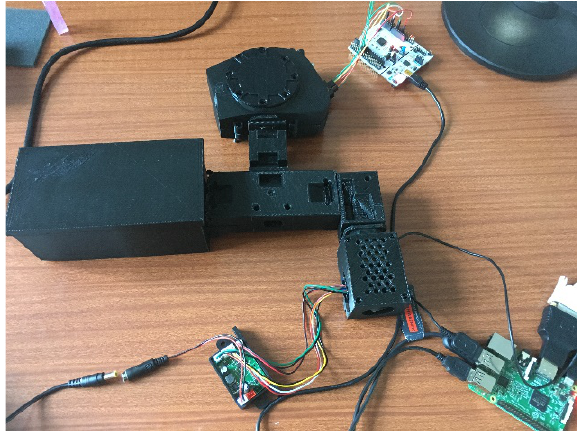
Fig. 6: Assembled 3D printed Raman